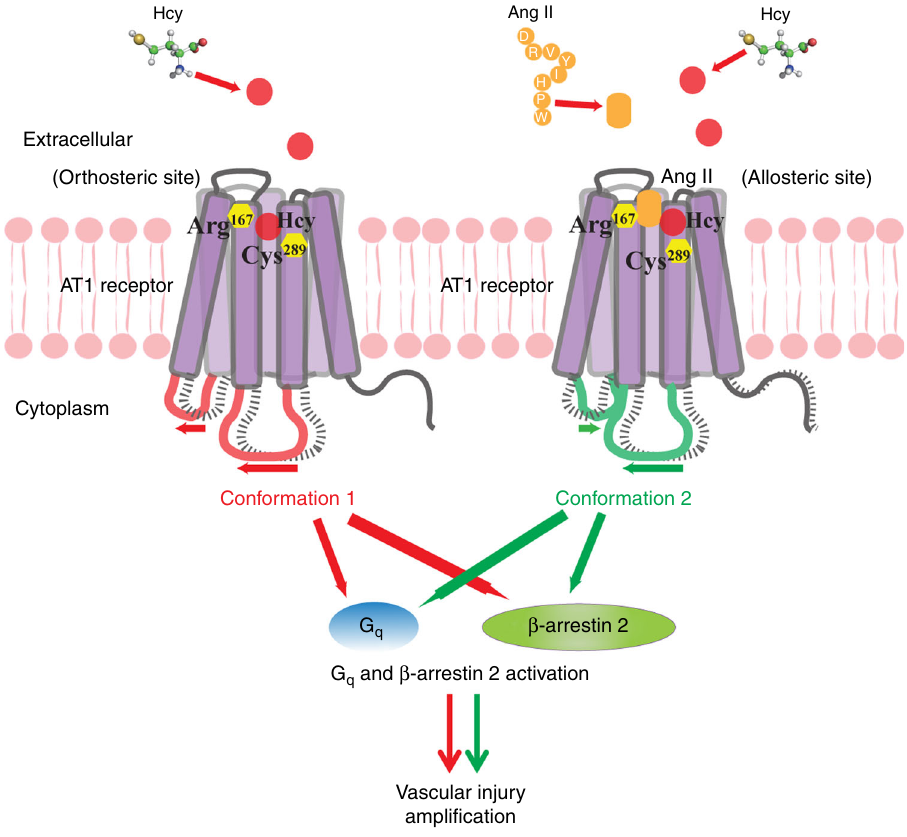
Fig. 7 Schematic diagram of Hcy-induced AT1 receptor activation and the Hcy-Ang II synergistic effect on the AT1 receptor. Hcy is an endogenous ligand and partial agonist of the AT1 receptor and directly activates the AT1 receptor via the Arg 167 and Cys 289 sites. Hcy causes a distinct conformational change of the AT1 receptor compared to Ang II. Hcy and Ang II synergistically activate the AT1 receptor and aggravate vascular